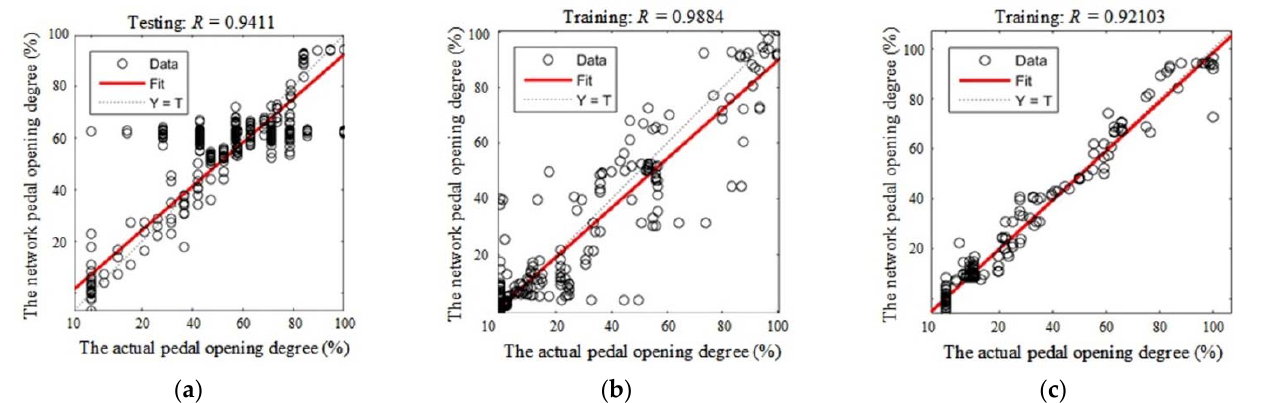
Figure 14. The testing results for the linear neural network: ( a ) the result for aggressive driving type; ( b ) the result for general driving type; ( c ) the result for steady driving type.